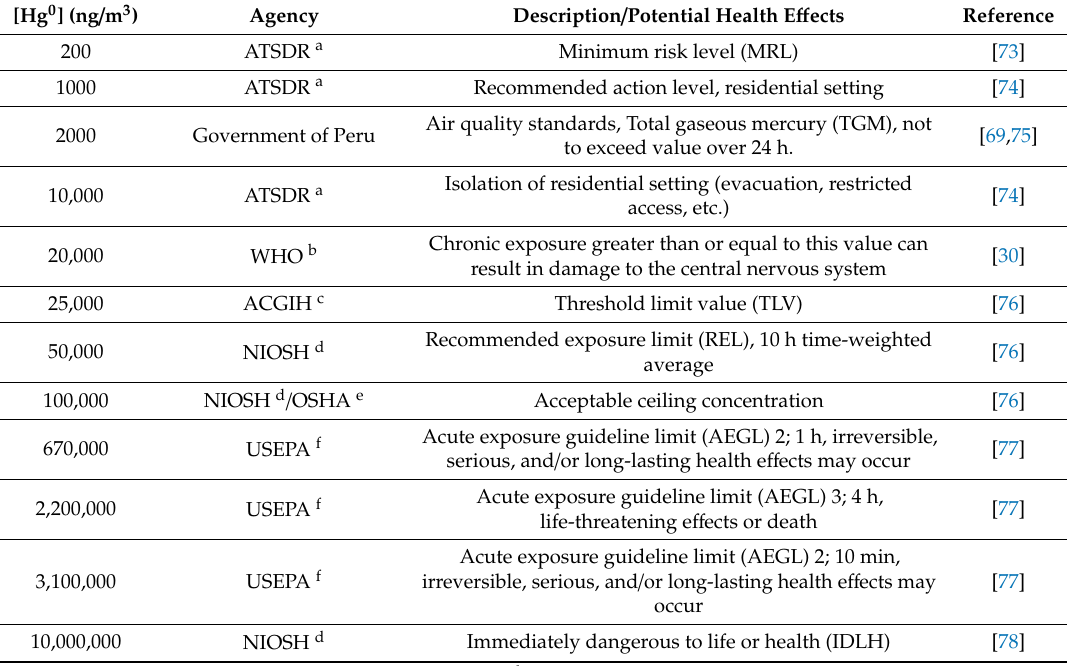
Table 2. Benchmark [Hg 0 ] in air and corresponding limits.